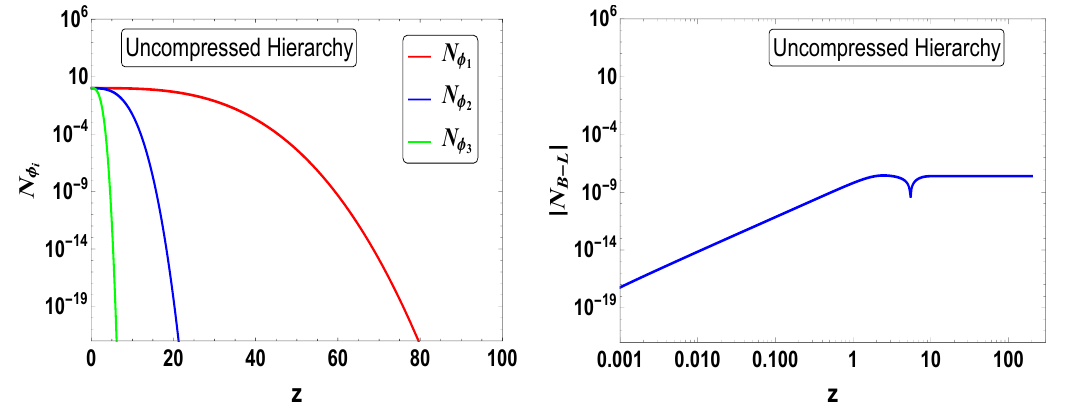
Figure 12 . Evolution of N φ (left) and N B − L (right) as a function of temperature T considering i uncompressed mass hierarchy among the scalars with { M φ → 10 7 , 10 9 , 10 11 } GeV and T r = 0 . 1 GeV i for the benchmark points I in table 2.